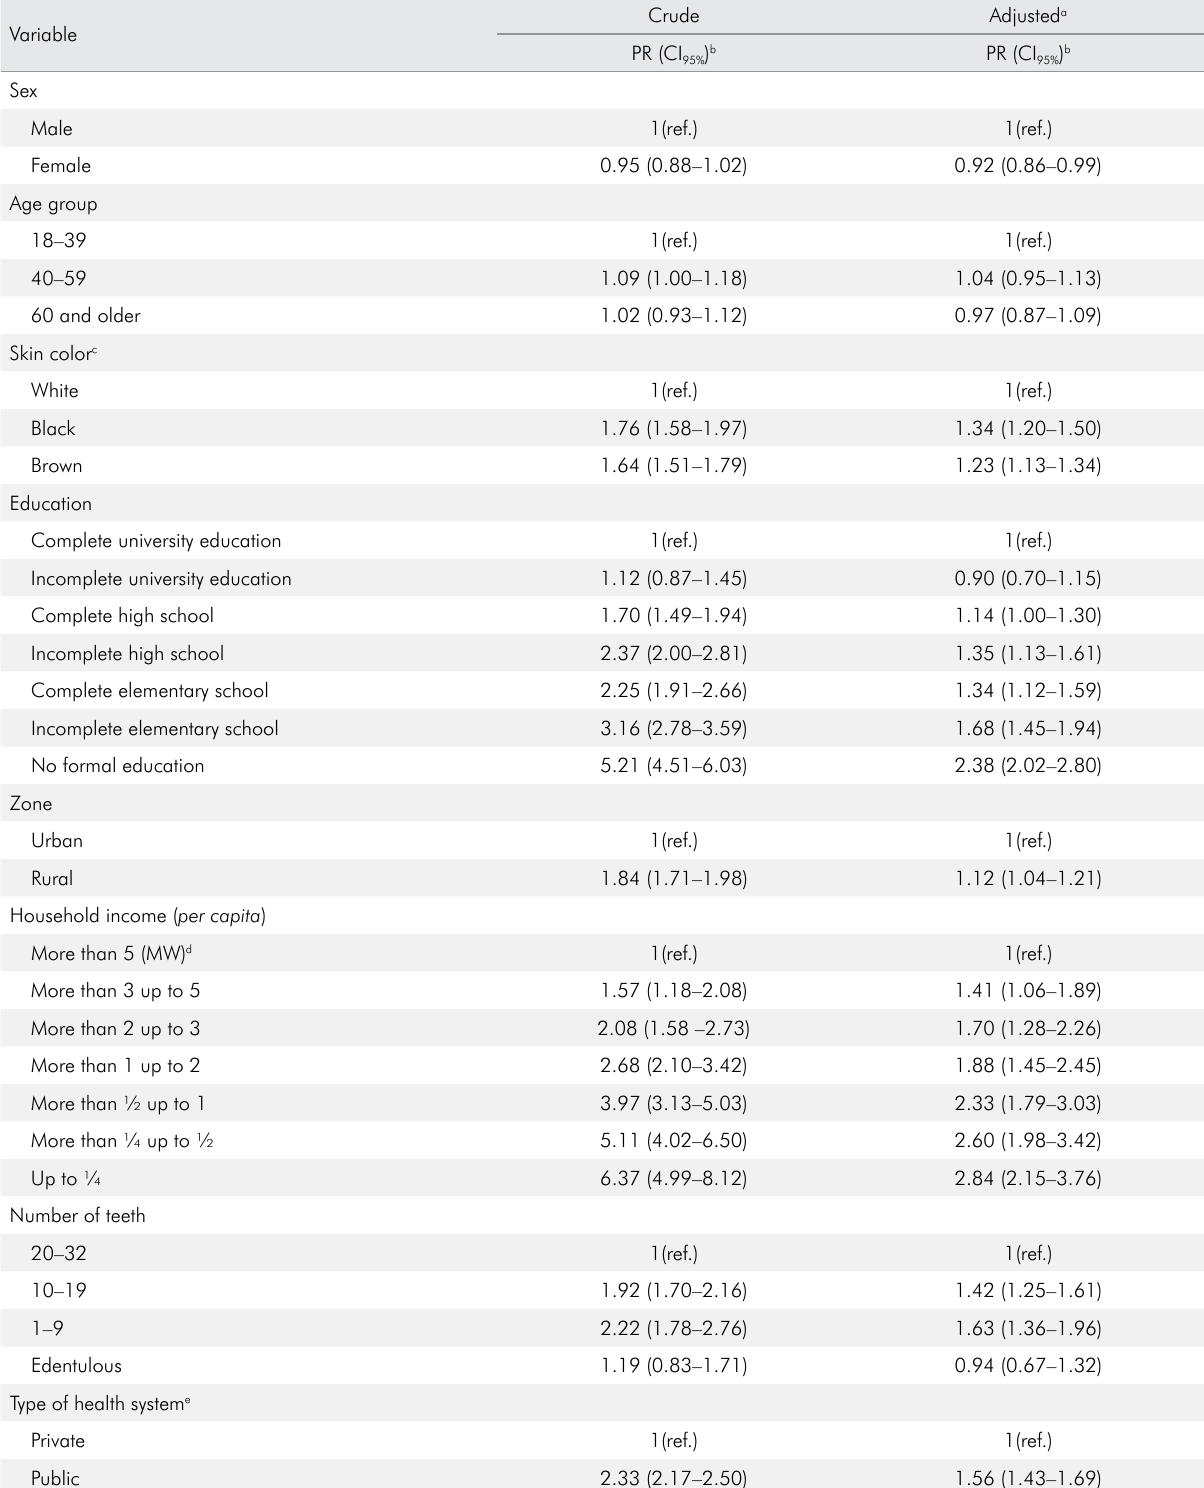
Table 3. Association between dental visits in the year prior to the data collection due to toothache or tooth extraction and exposures: prevalence ratio and its 95%CI. National Health Survey (PNS), 2019. All analysis were adjusted for the sample’s